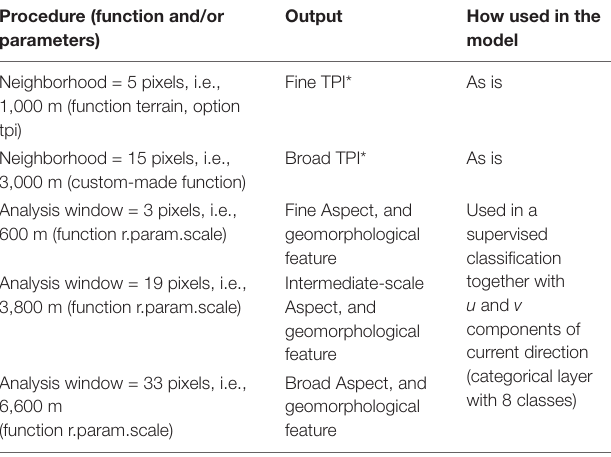
TABLE 1 | Summary of multiscale analyses performed on bathymetric